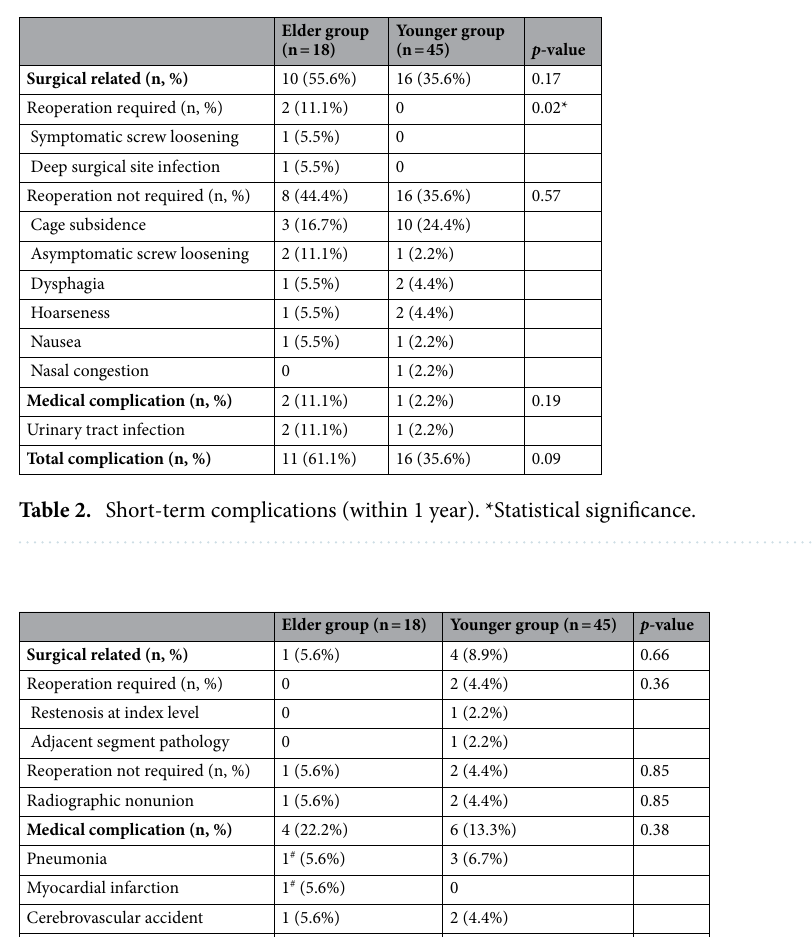
Table 3. Middle-term complications (onset more than postoperative 1 year). # Two mortalities: one patient died of pneumonia and sepsis at postoperative 6 years, the other patient died of acute myocardial infarction at postoperative 8 years.